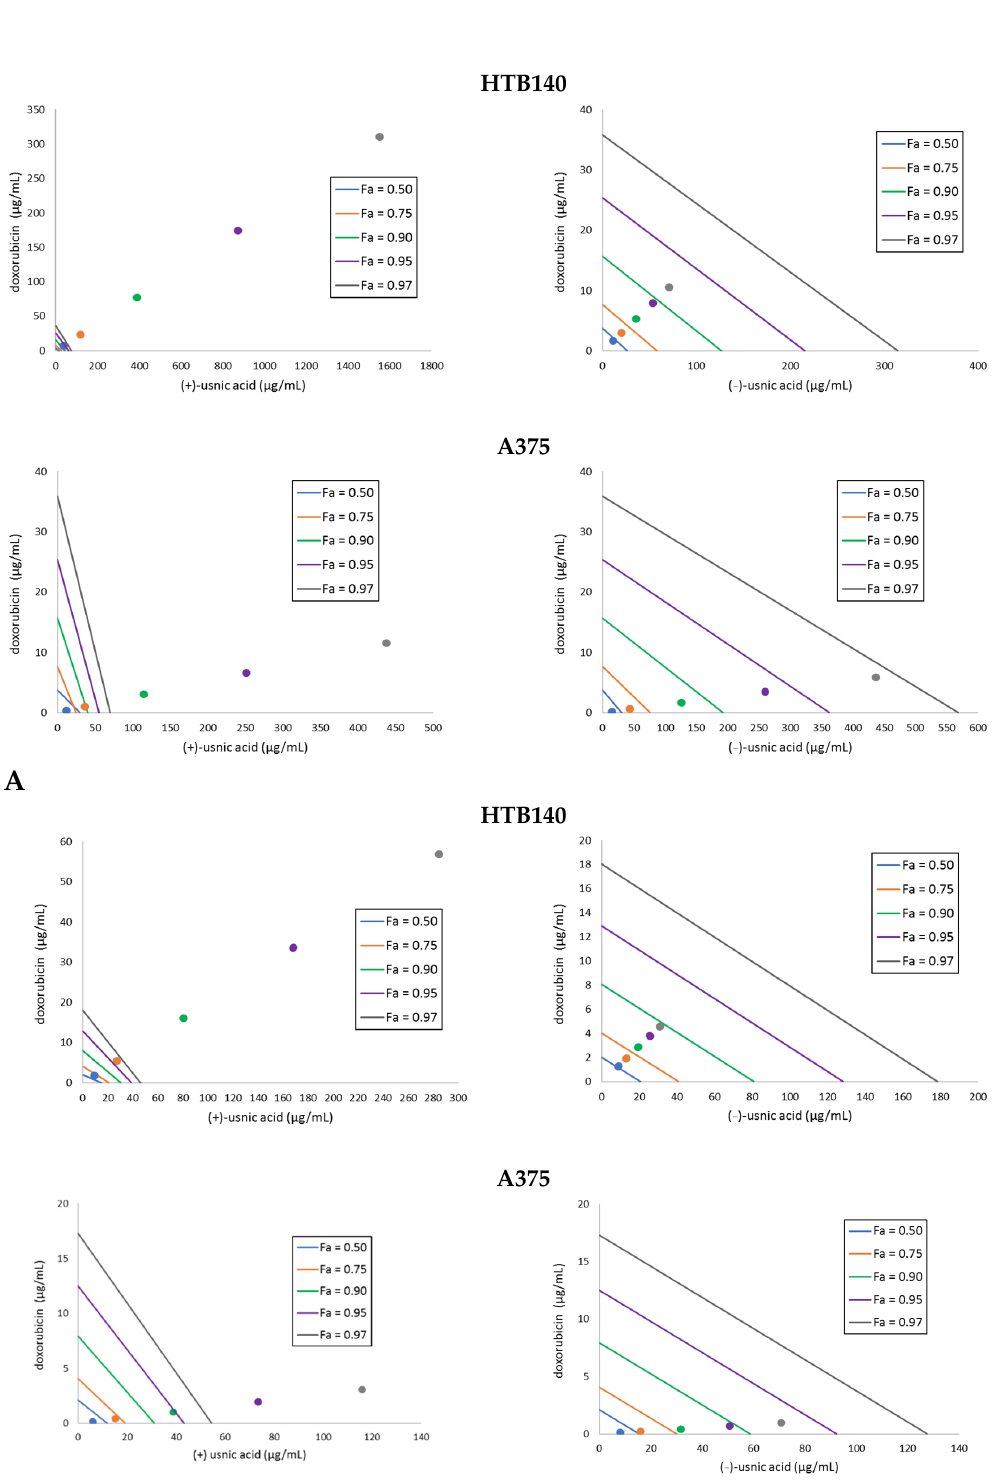
Figure 1. Isobolograms for the combinations of usnic acid enantiomers with doxorubicin to HTB140 and A375 melanoma cells, after 24 h ( A ) and 48 h ( B ) of incubation. Points on x ‐ and y ‐ axes, connected by the line, represent median doses (Fa = 0.50 means IC 50 , Fa = 0.75 means IC 75 , Fa = 0.90 means IC 90 , Fa = 0.95 means IC 95 , Fa = 0.97 means IC 97 ) of the substances given alone, whereas the dots represent appropriate combinations of both substances, respectively. Dots below the lines of the same colour indicate synergy, dots on the line of the same colour indicate additive effect, whereas the dots over the lines of the same colour indicate antagonism of the interaction.